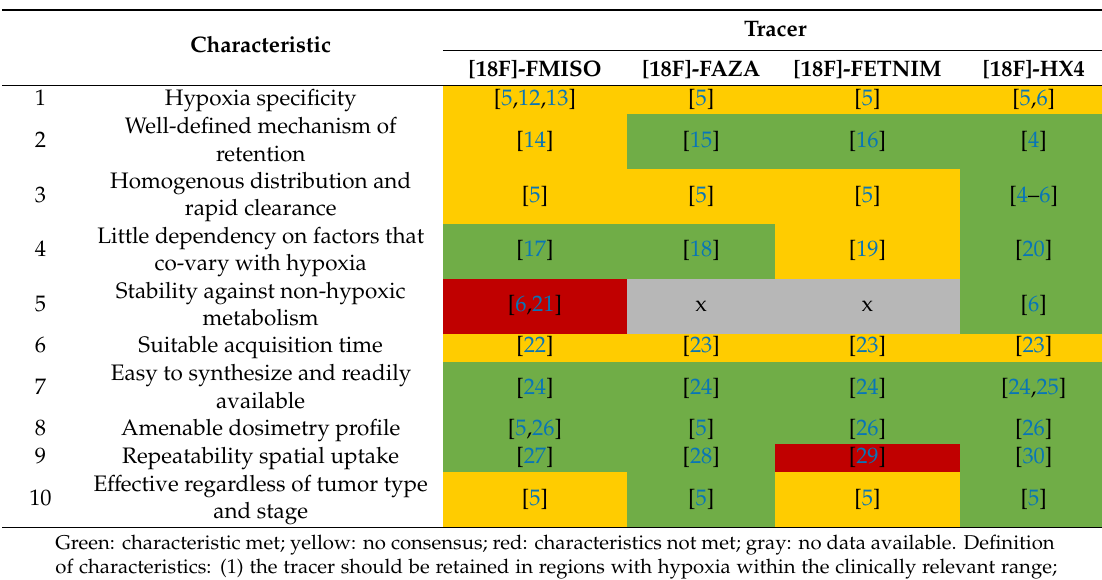
Summary of the four currently most used and tested 2-nitroimidazole hypoxia positron-emission tomography (PET) tracers ([18F]-FMISO, [18F]-FAZA, [18F]-FETNIM, [18F]-HX4), and how these compare to the characteristics of the ideal hypoxia PET